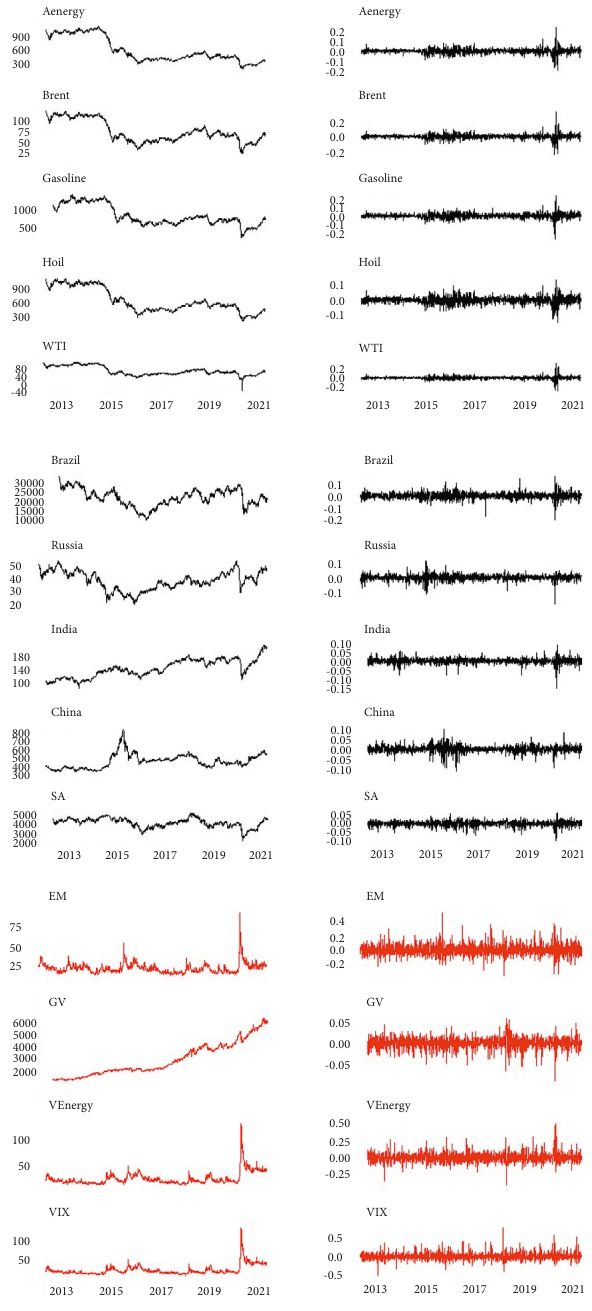
Figure 1: Plots of raw and returns